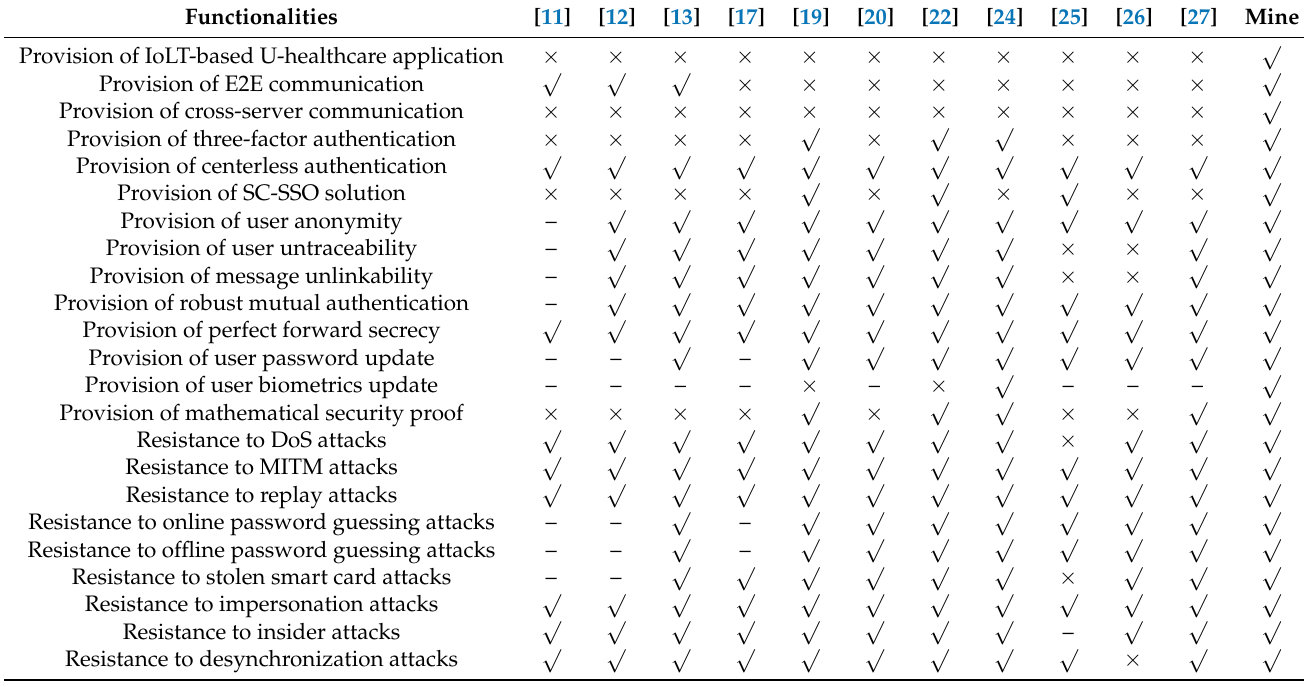
Table 3. Comparison of functionalities and security